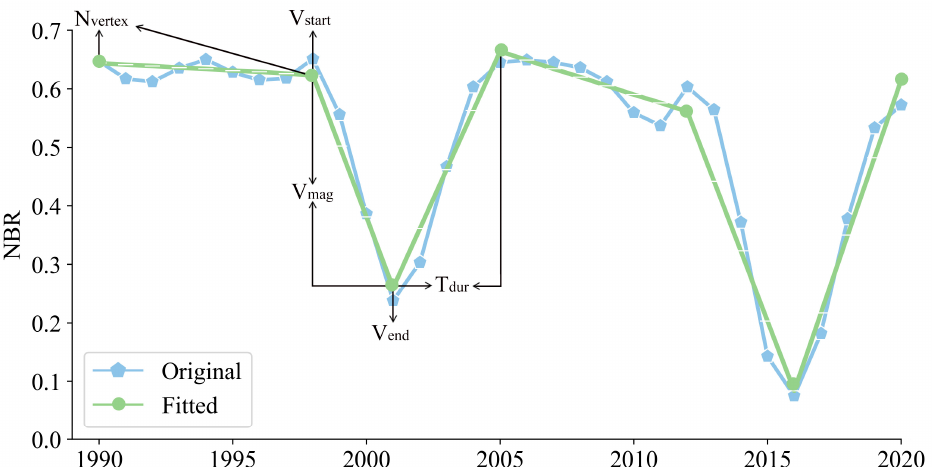
Figure 3. Metrics calculated for optimizing the LandTrendr algorithm.